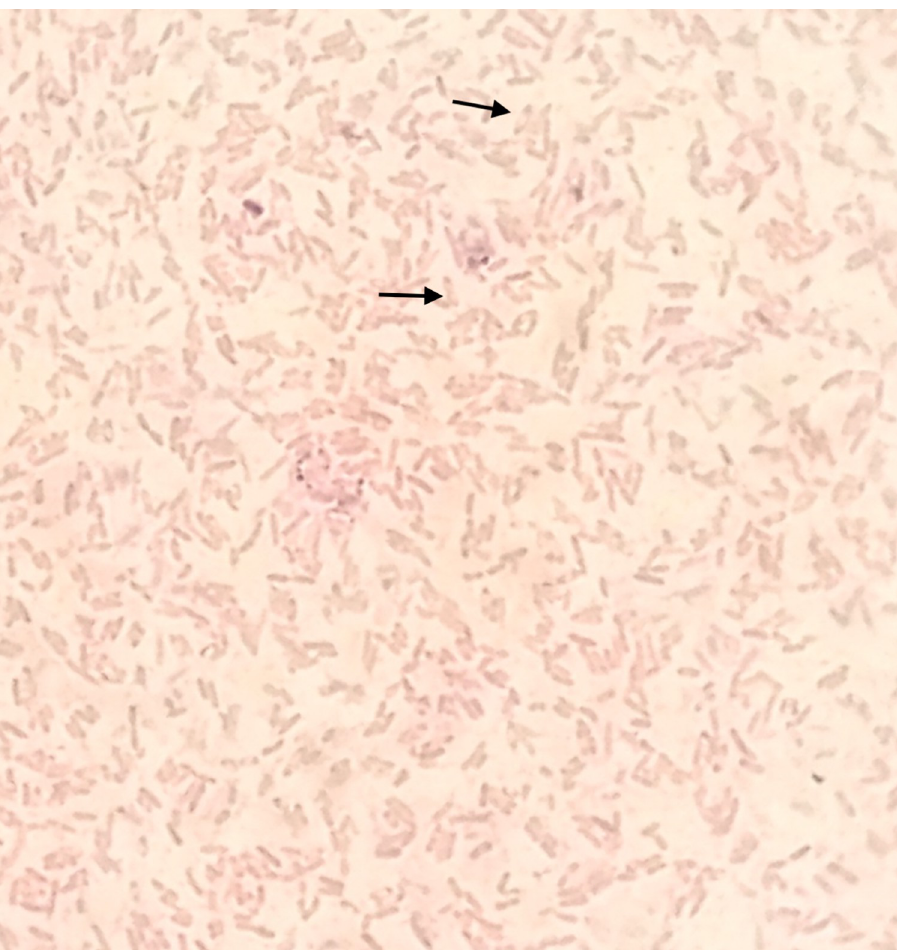
Fig 2. Gram staining showing gram-negative bacilli with safety-pin